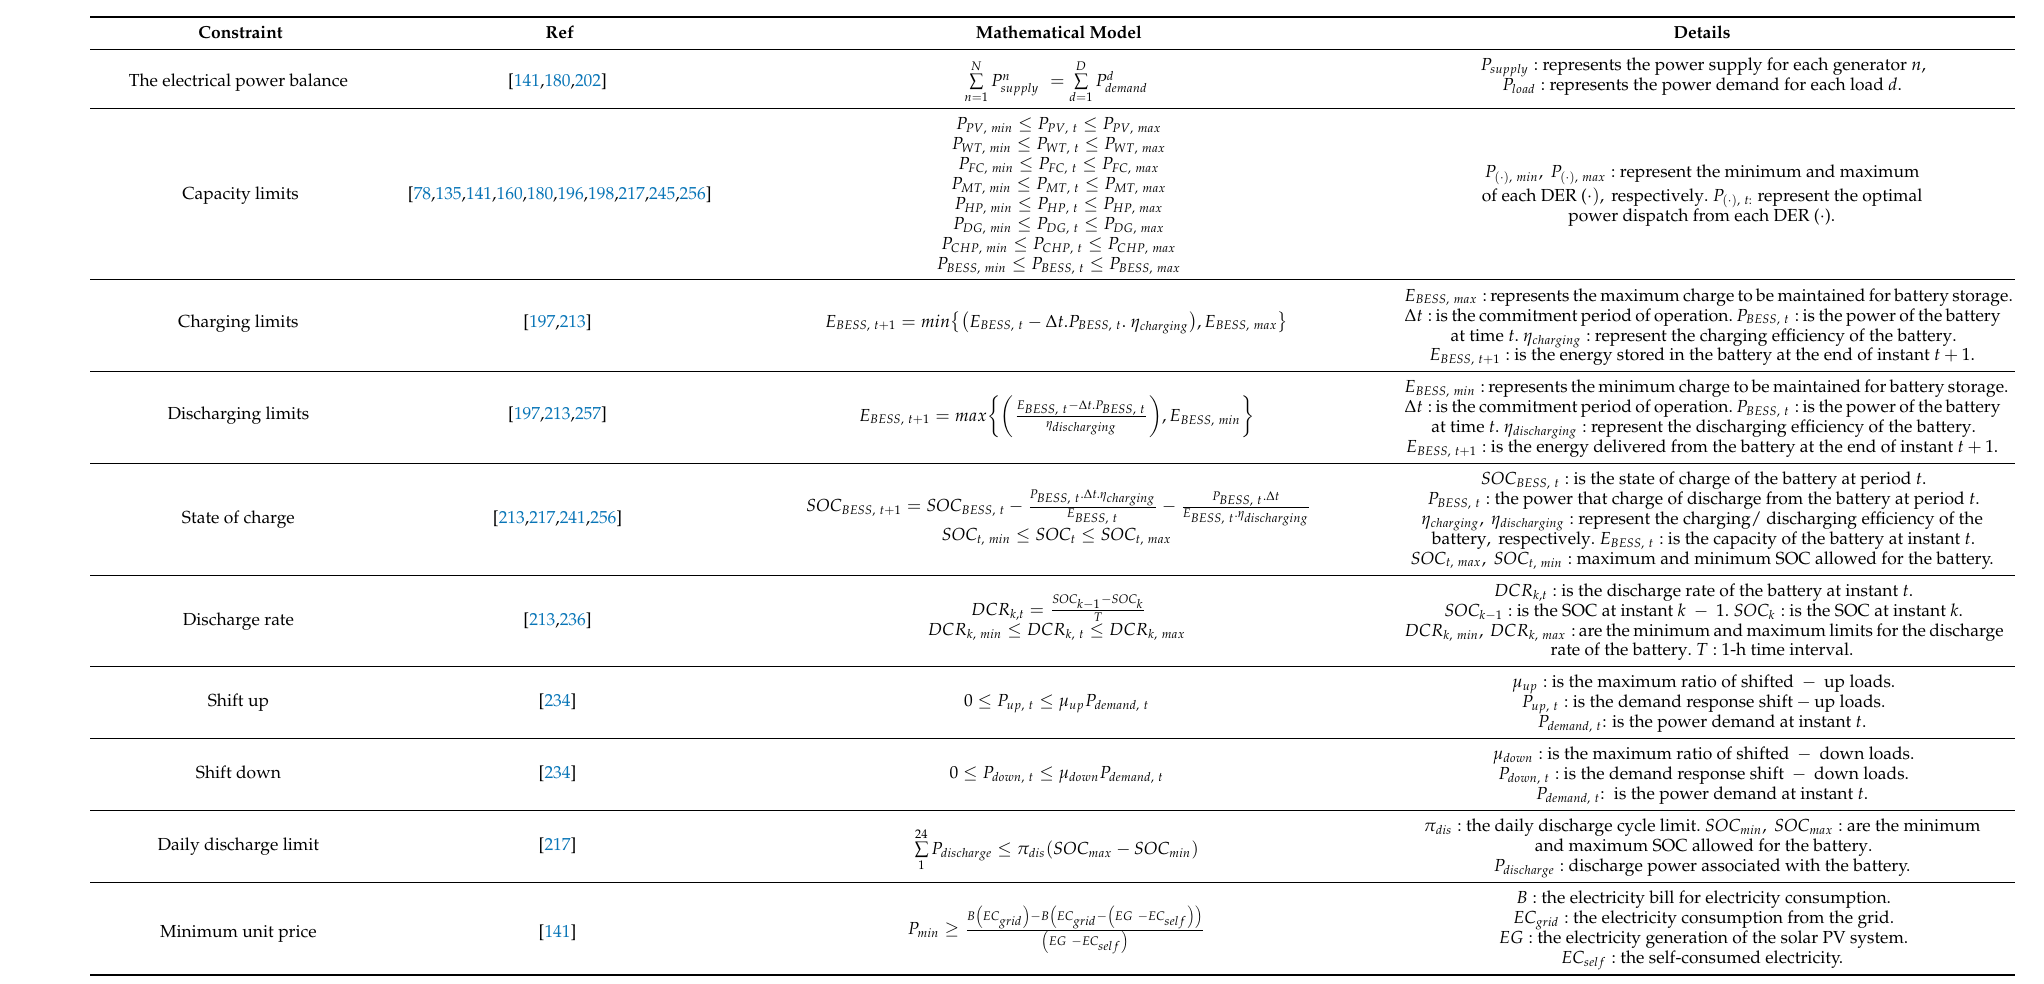
Table 10. Various energy management system constraints used in energy market optimization